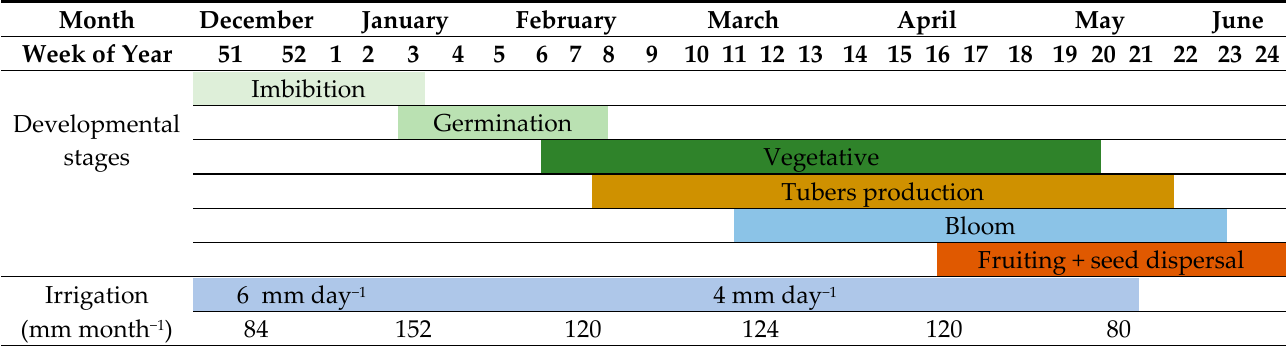
after germination and thereafter, during the vegetative phase. The tubers are located on roots at a depth of 5–20 cm and are typically small and spherical (1–2 cm in diameter). Bedouin ethnobotanical wisdom holds that the tubers are edible and as such local Bedouin tribes are their primary users [8]. HSB tubers have a light sweet taste, and their best quality is in late winter or early spring, when they are whitish in color [8]. Table 1. Life cycle and phenological development of HSB as observed in our irrigated fields.